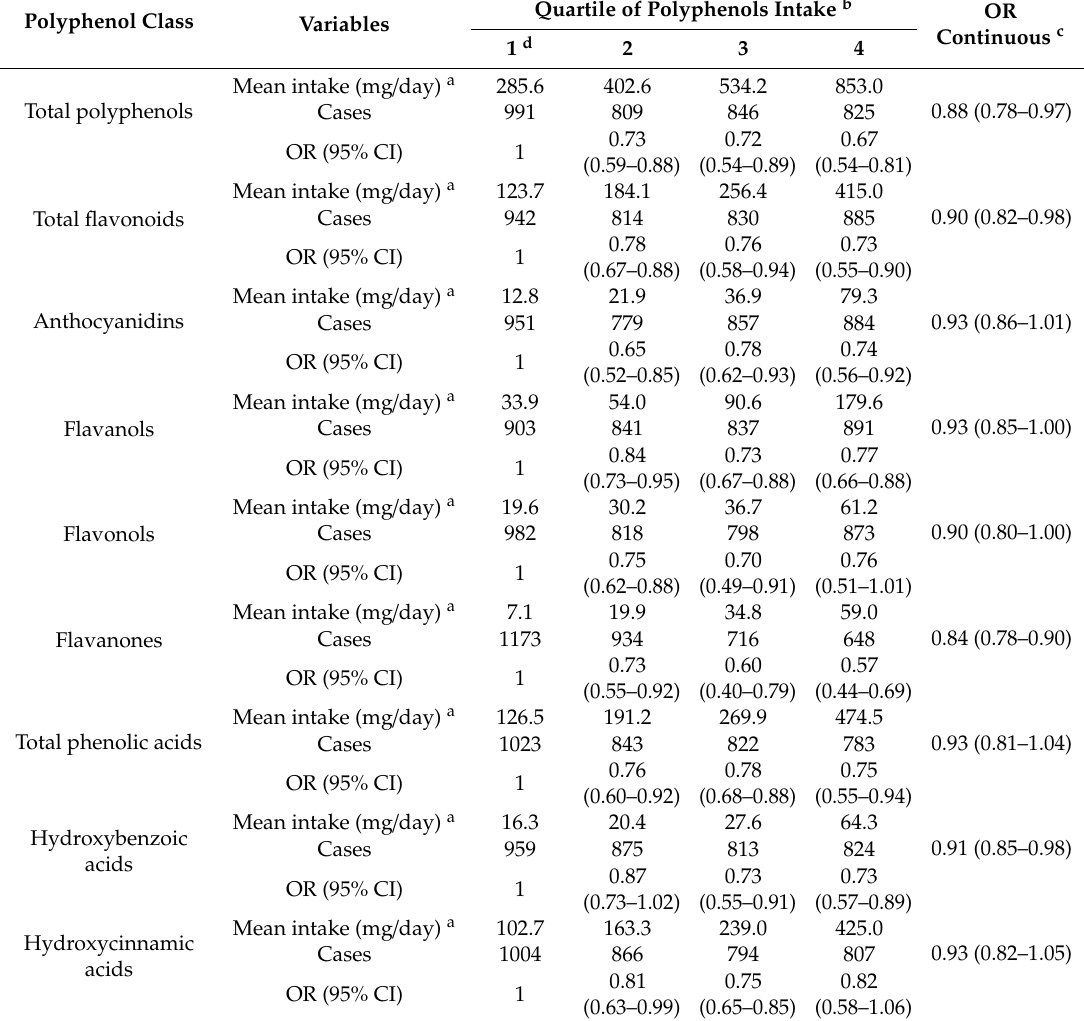
Table 2. Distribution of 3471 gastric cancer cases and 8344 controls according to quartile of intake of selected polyphenols and corresponding odds ratio (ORs) and 95% confidence intervals